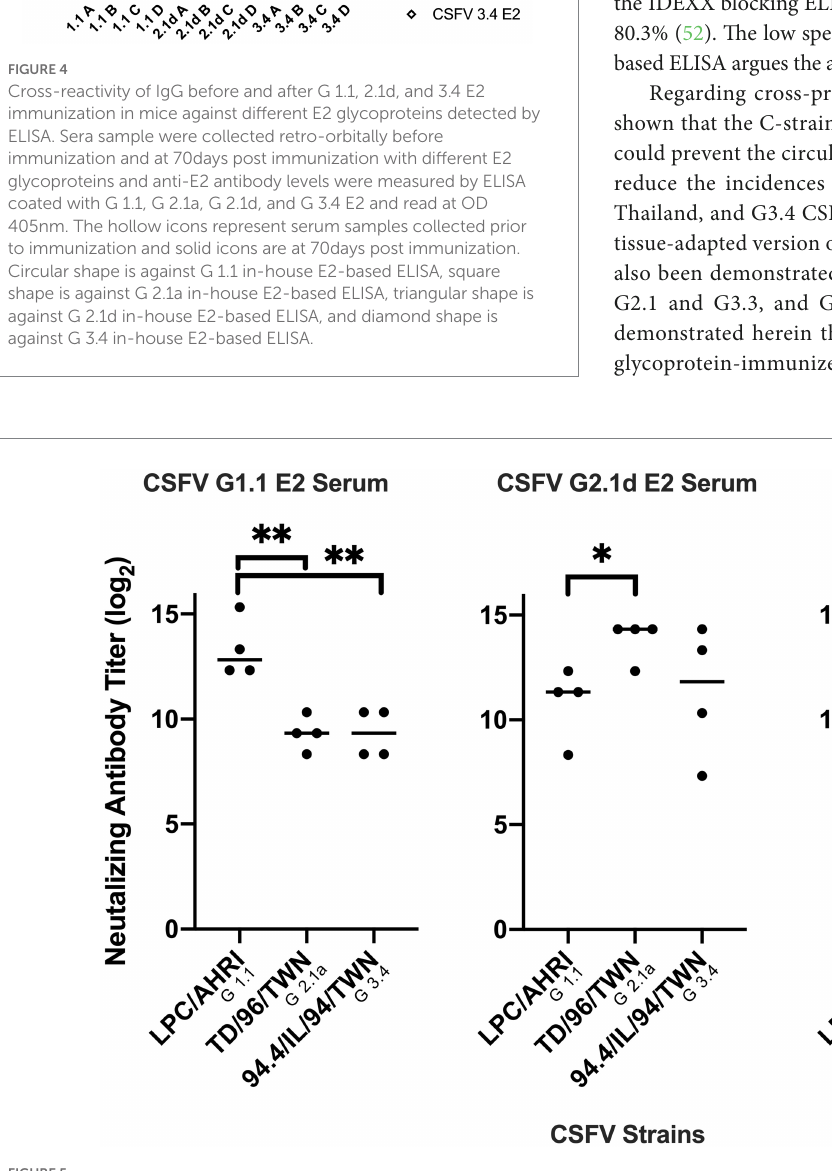
FIGURE 5 Comparison of different mice serum neutralizing antibody titer against different CSFV genotypes. Mice sera at 70 days after immunization with G 1.1, G 2.1d, or G 3.4 glycoproteins were collected, inactivated at 56 ° C, incubated with 100 TCID50 of LPC/AHRI strain (G 1.1), TD/96/TWN strain (G 2.1a), or 94.4/IL/94/TWN strain (G 3.4) of CSFV for 1 h at 37 ° C, and infected PK-15 cells. The highest dilution that is able to stop 50 percent of the cell from infection were recorded. * p < 0.05; ** p <